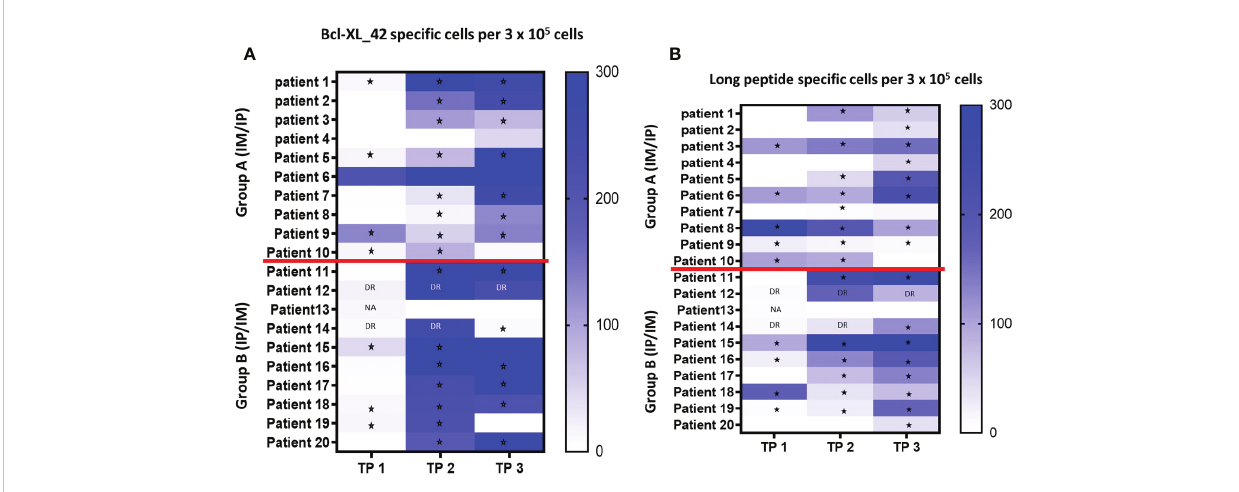
FIGURE 2 (A, B) Elispot analysis of PBMCs from all twenty patients at TP1 (before vaccination), TP2 (after three vaccinations), and TP3 (after six vaccinations). (A) PBMCs have been pre-stimulated with the vaccine peptide (BCL-XL_42) for 14 days before being restimulated with Bcl-XL_42, or (B) restimulated with the long peptide pool containing four HLA-class II in silico predicted peptides. Background spots were subtracted from the BCL-XL_42 wells. * P<0,05 statistically signi fi cant response based on DFR analysis. DR “ Double Response ” – the number of spots in peptide wells are 2x higher than control, cannot be statistically con fi rmed due to replicate number. NA Not able to do statistics due to duplicate and not triplicate. TNTC is too numerous to count (> 500). Patient 12 (all TPs), 13 (TP1), and 14 (TP1 and TP2) were not included because the ELISPOT were done in duplicates, and therefore it was not possible to do statistical